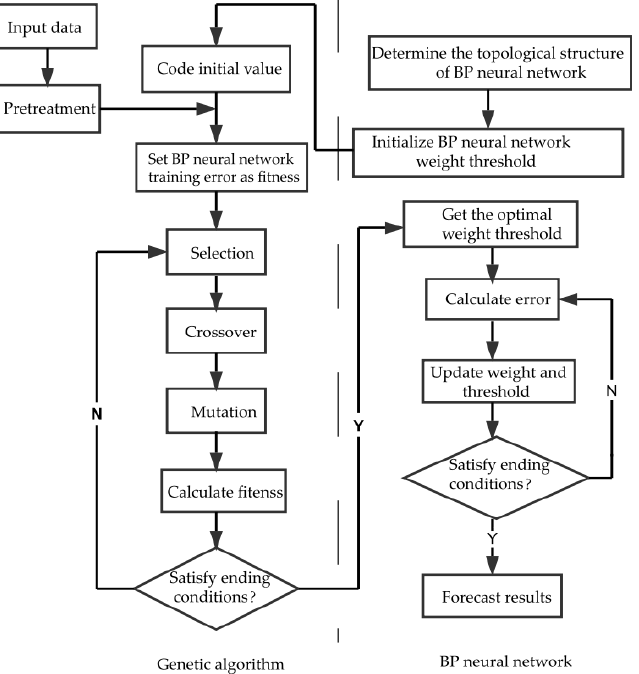
Figure 13. Genetic algorithm optimization flow chart.